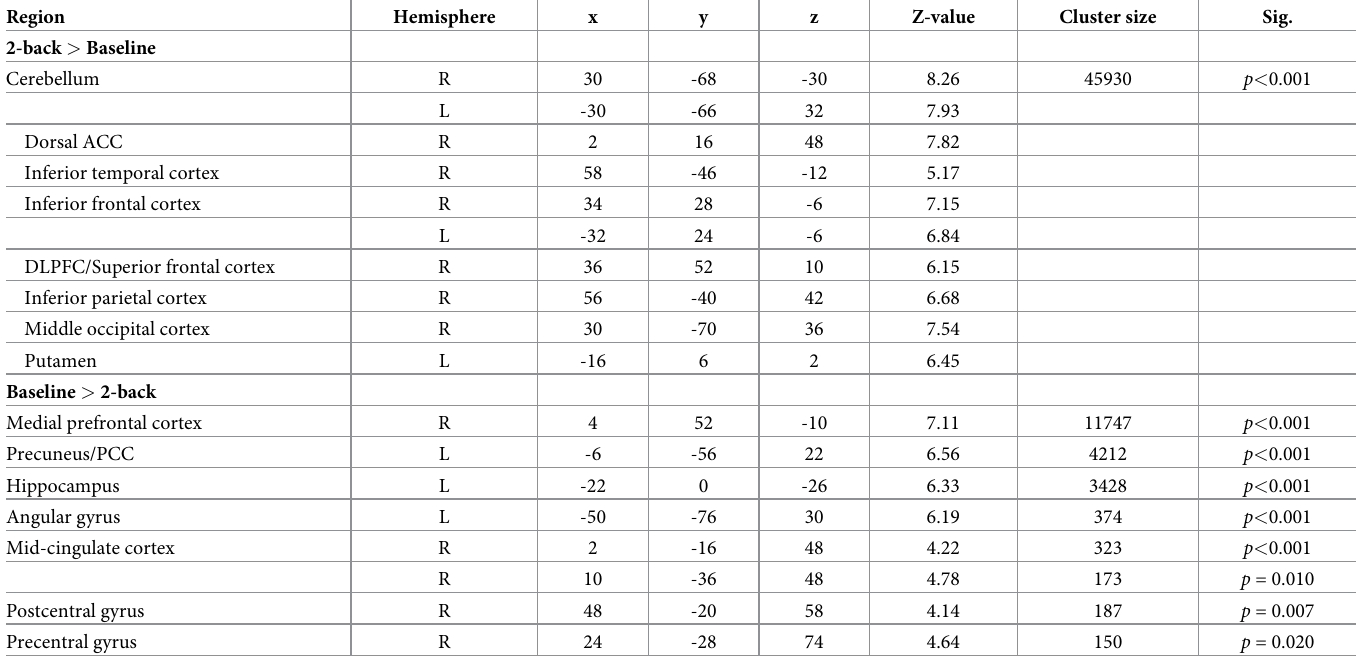
Table 4. Significant activation in the n-back task.